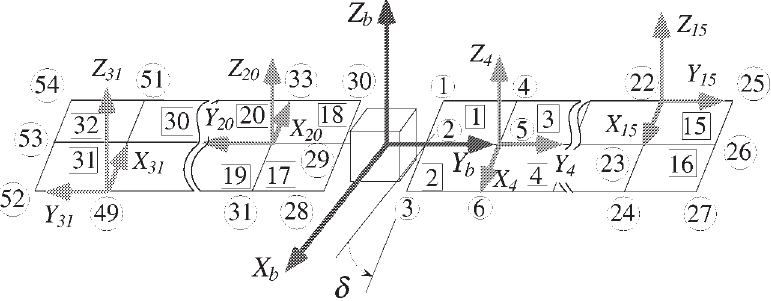
Fig. 3. The model of satellite being investigated; element numbering, nodal point numbering, rigid main body fixed reference frame, and local reference